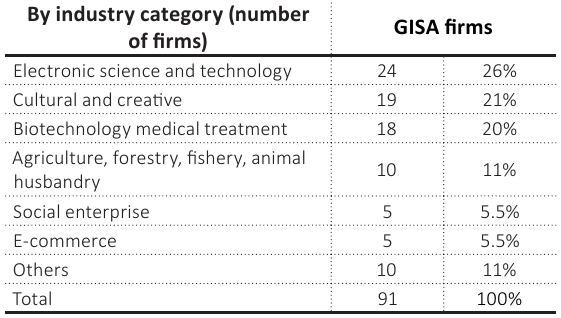
Table 3. Sample by industry